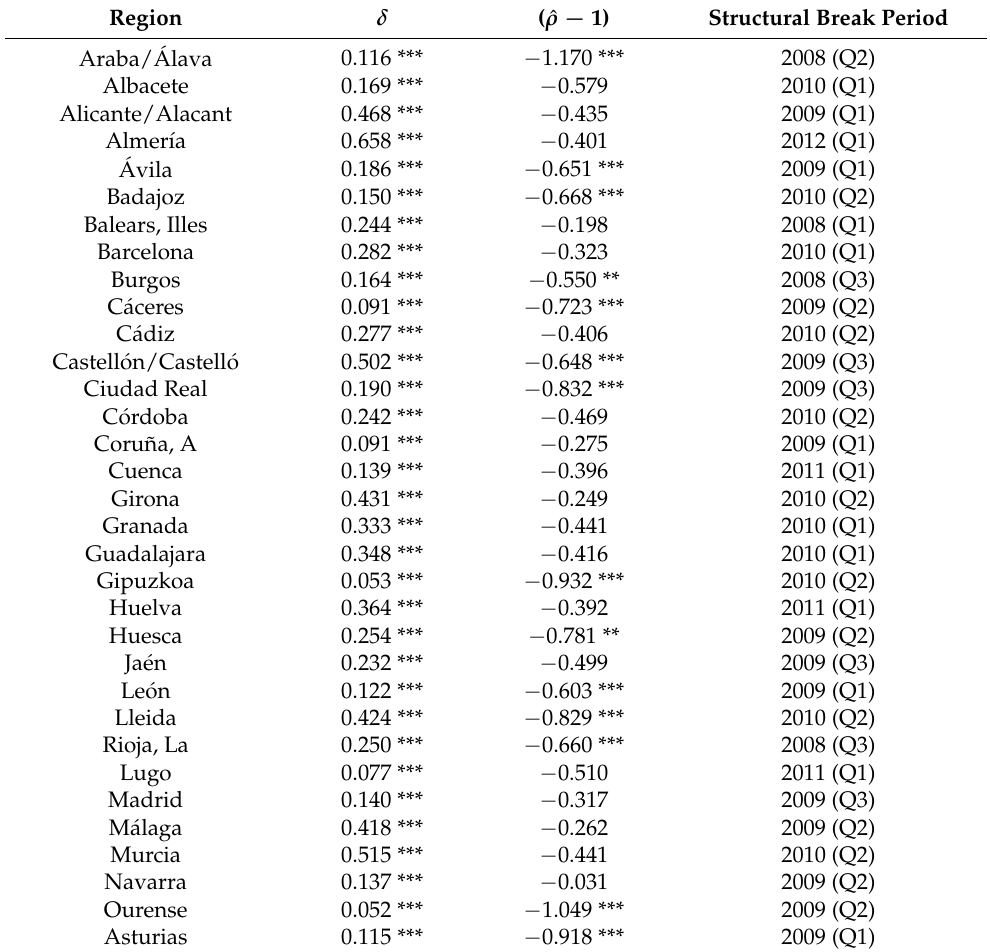
Table 3. Unit root tests on foreclosure rates with one structural break. Region δ ( ˆ ρ − 1) Structural Break